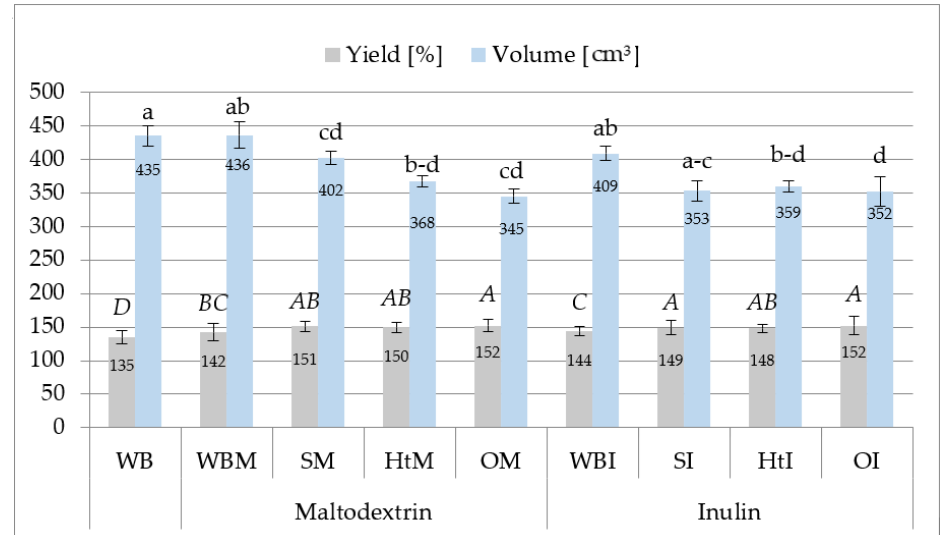
Figure 2. Yield (%) and volume (cm 3 ) of different samples of wheat bread. Abbreviations: WB— wheat bread; WBM—wheat bread with maltodextrin; SM—wheat bread enriched with soy extracts in maltodextrin; HtM—wheat bread enriched with hawthorn extracts in maltodextrin; OM —wheat bread enriched with onion husk extracts in maltodextrin; WBI—wheat bread with inulin; SI—wheat bread enriched with soy extracts in inulin; HtI—wheat bread enriched with hawthorn extracts in inulin; OI—wheat bread enriched with onion husk extracts in inulin. Values with different letters were significantly different at p = 0.05 according to Duncan’s test. The data are expressed as mean ( n = 3).